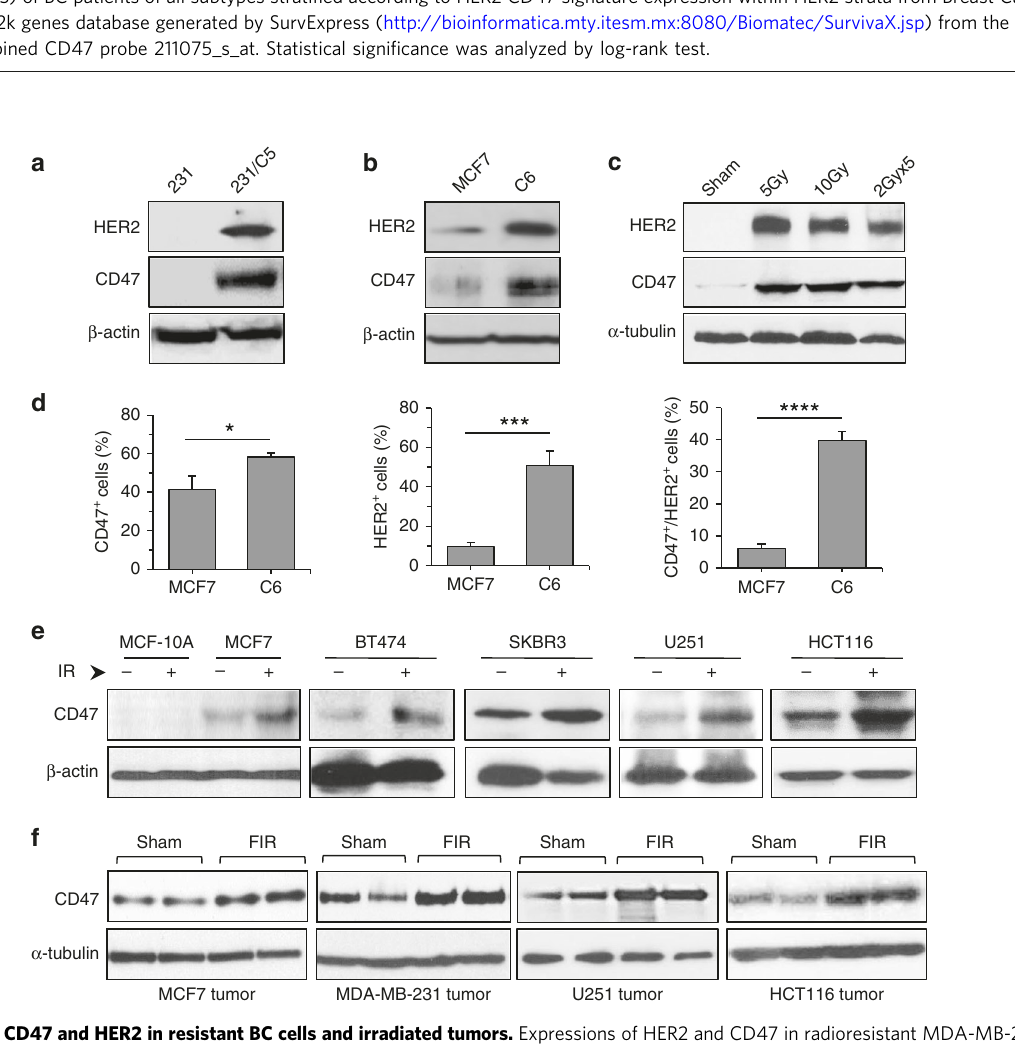
Fig. 2 Induction of CD47 and HER2 in resistant BC cells and irradiated tumors. Expressions of HER2 and CD47 in radioresistant MDA-MB-231/C5 cells ( a ) in radioresistant MCF7/C6 cells ( b ) both were derived from surviving clones after FIR. c Expression of HER2 and CD47 in syngeneic mouse 4T1 breast tumors 16 h after local RT with single-dose radiation or FIR (pooled samples from six tumors). d Enhanced CD47 + /HER2 + population in MCF7/C6 cells compared to parental MCF7 cells measured by fl ow cytometry ( n = 3; * P < 0.05, *** P < 0.001, **** P < 0.0001). e Induction of CD47 by radiation in an array of human cancer cells (breast cancer MCF-7, BT474, SKBR3, glioblastoma U251, and colorectal carcinoma HCT116 cells) measured by immunoblotting 16 h after radiation (5 Gy). f Induction of CD47 expression in xenograft tumors (duplicated samples from each tumor group) following RT with fractionated doses (FIR, 2 Gy ×